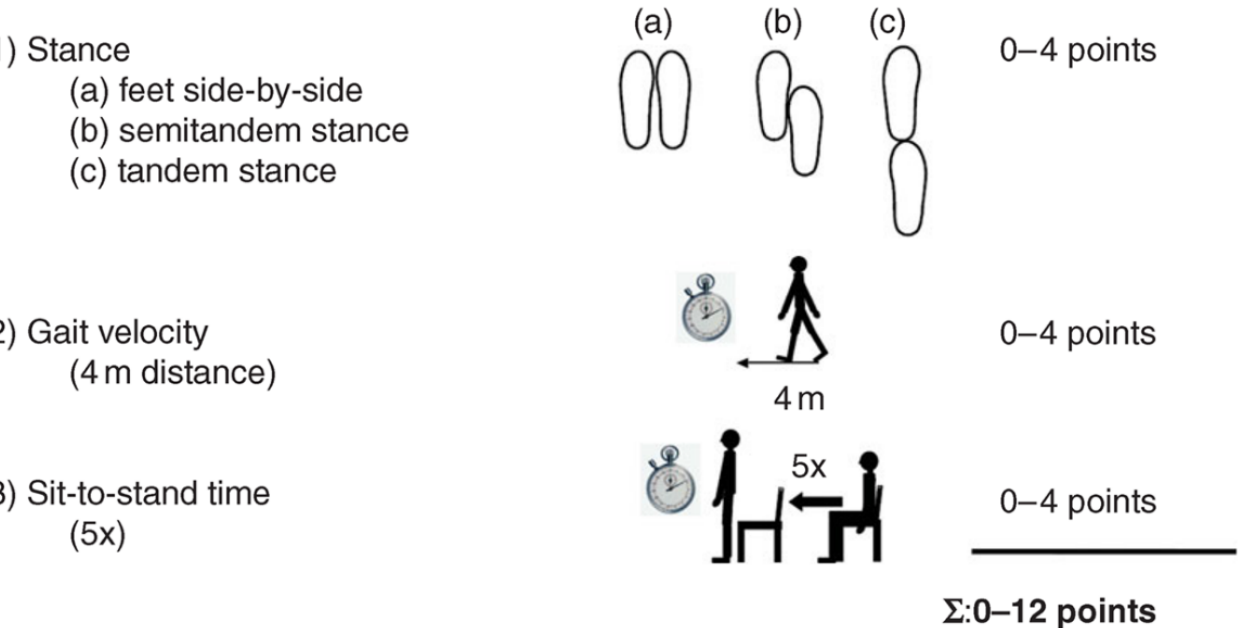
Figure 2. Illustrative image of the activities carried out at SPPB. (1) Balance test: ( a ) feet side-by-side position; ( b ) semitandem position; ( c ) tandem position.